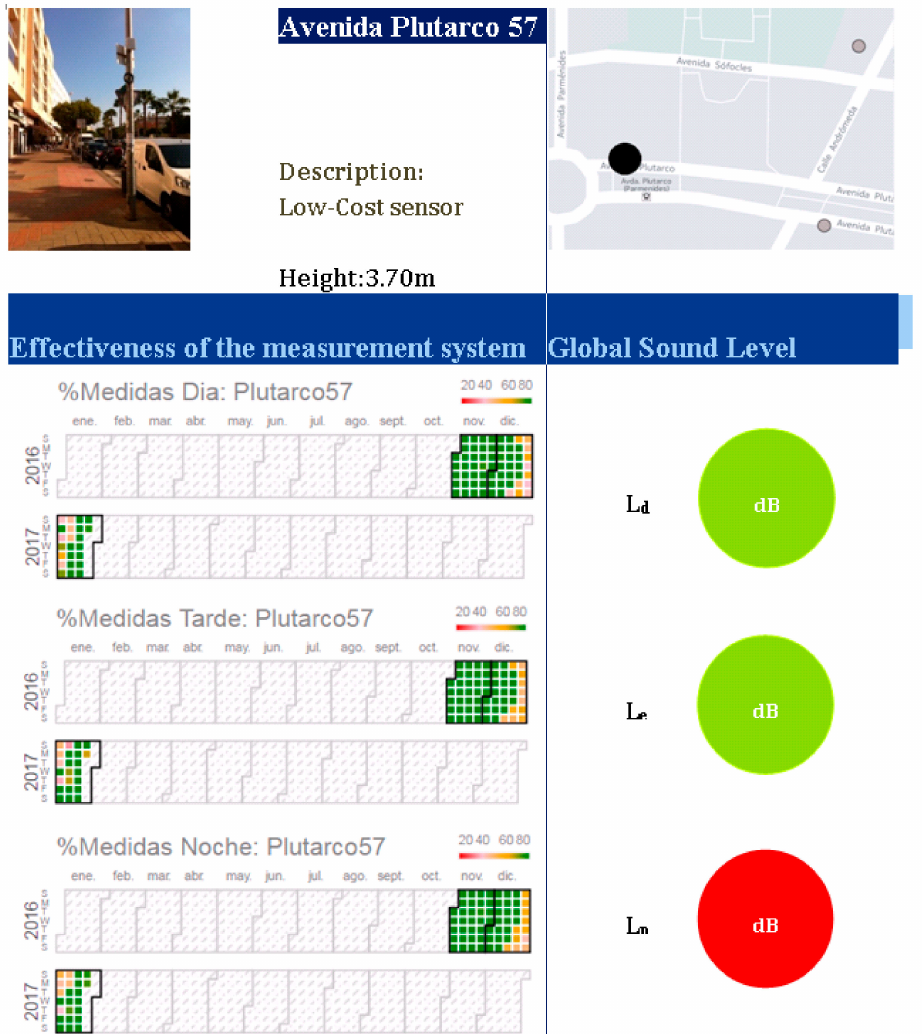
Figure 12. Information template used for each measurement